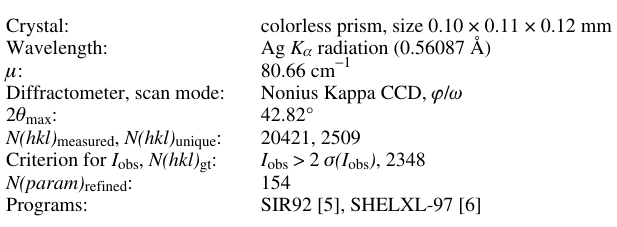
Table 1. Data collection and